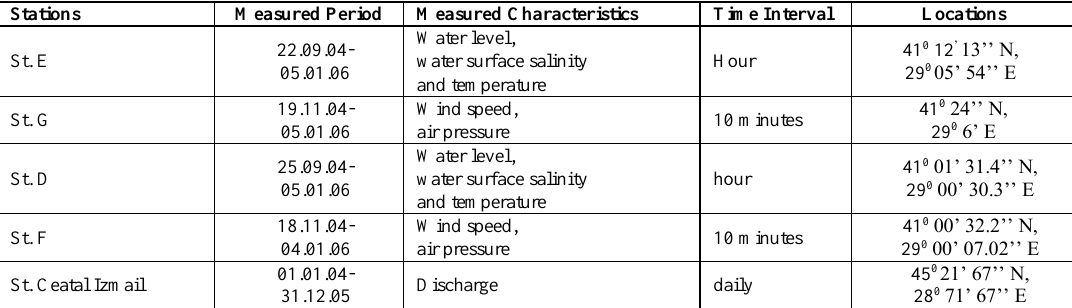
Table 1. Measurement locations and durations.